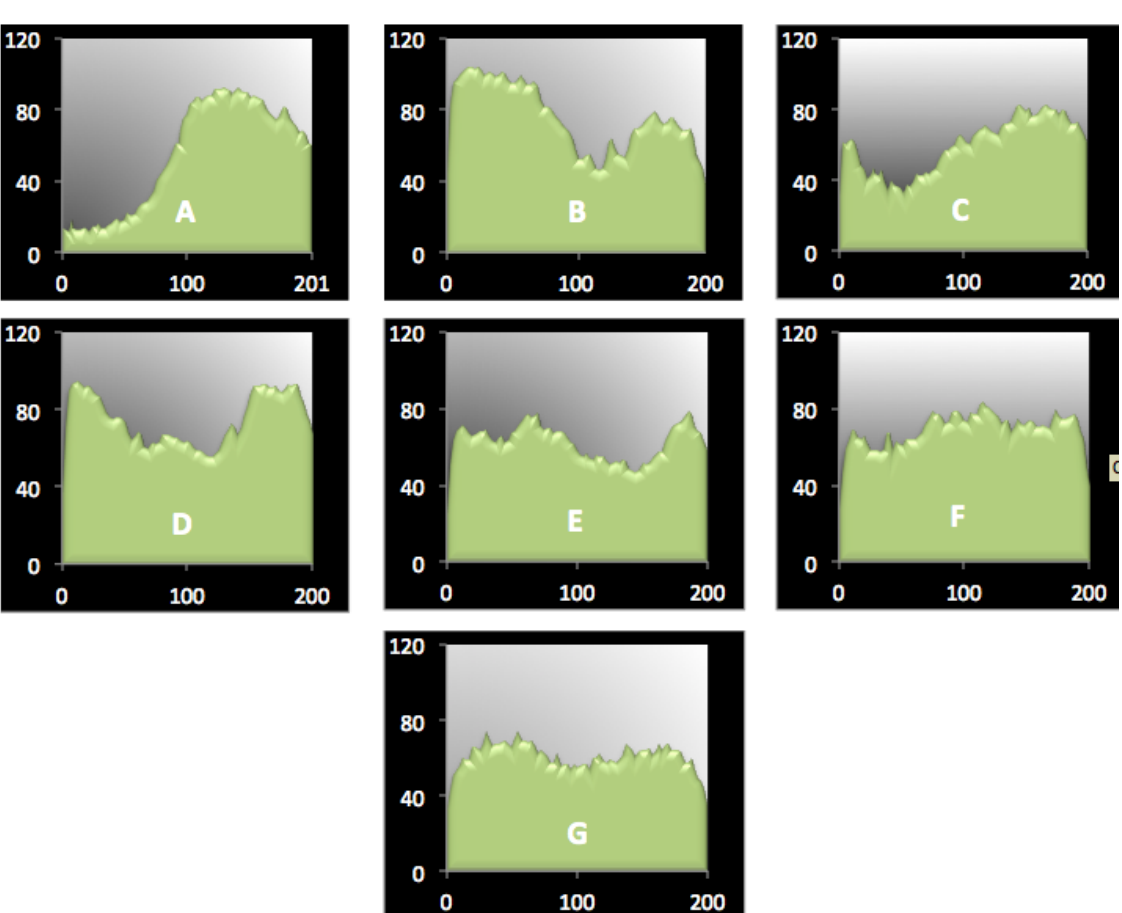
Figure 11. Fluorescence intensity along the channel width at selected points A, B, C, D, E, F, and G at Re number of